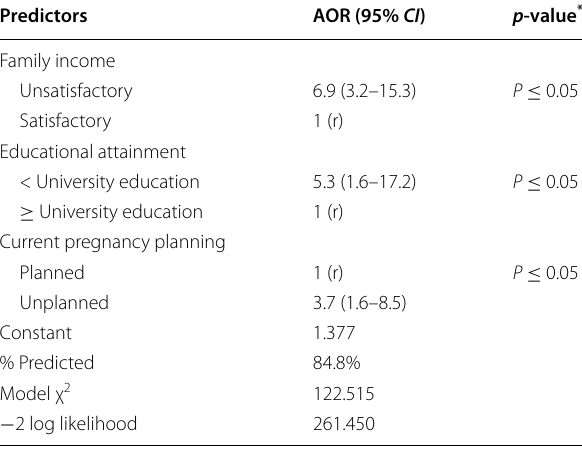
Table 4 Multivariate logistic regression analysis for determining the predictors of limited HL in pregnant women ( n on forward Wald